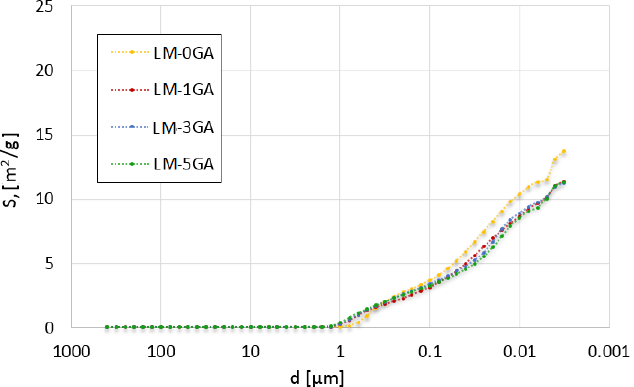
Figure 6. Differential volume of intruded mercury versus pore diameter for the tested lime-metakaolin pastes.